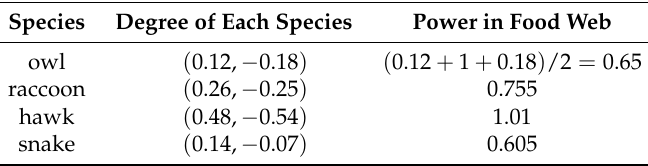
Table 8. Strength of competition between